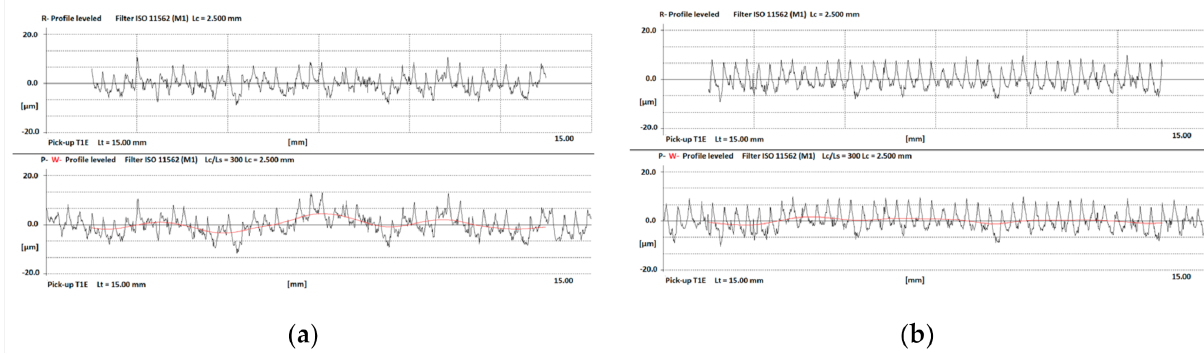
Figure 6. R, W, and P profiles of the eighth machined sample (L/D = 6; S355JR): ( a ) section 1, ( b ) section 2.